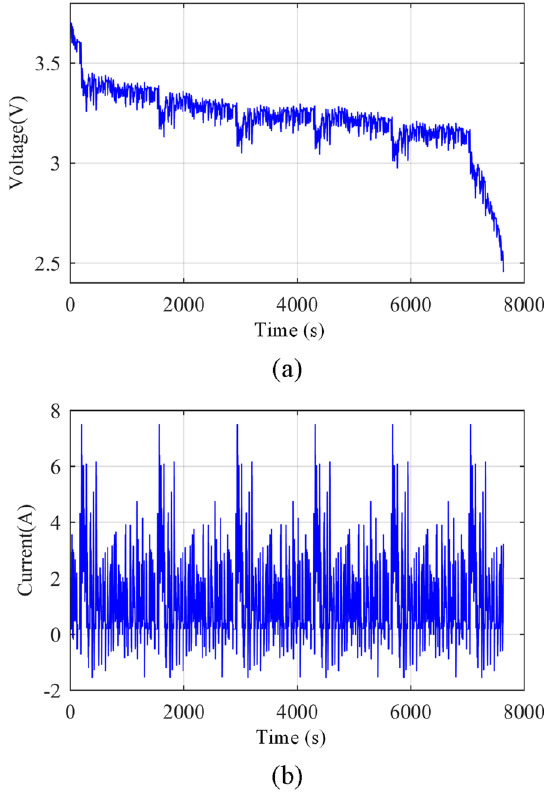
Figure 6 Voltage and current profiles in the simulation test: ( a ) voltage, ( b )